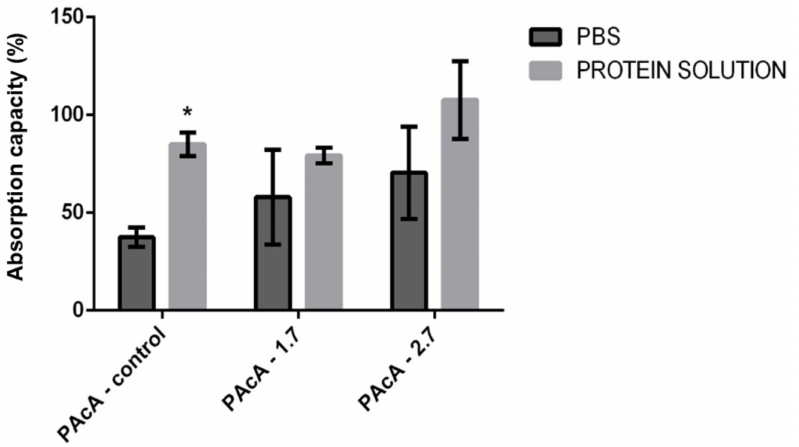
Figure 7. Evaluation of the fluid absorption capacity of PCL control polymeric films (PAcA-control) and incorporated with andiroba oil (PAcA-1.7 and PAcA-2.7) immersed for one hour in aqueous or protein solution. The data were plotted in the average format and standard error of the mean. The analysis was performed by 2-way ANOVA followed by Bonferroni’s test, with p < 0.05, n = 4. The asterisk (*) indicates a significant difference between the control and treated